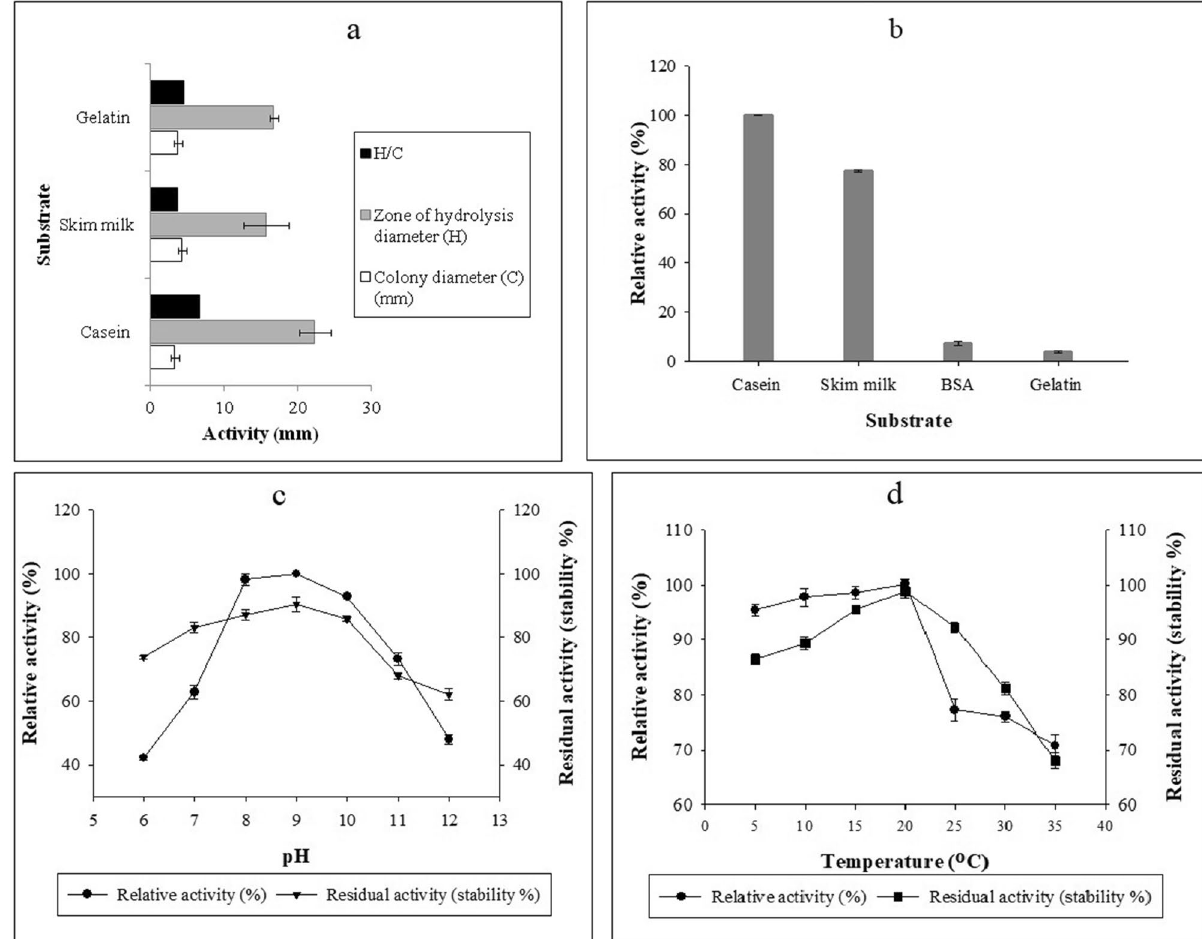
Figure 1. ( a ) Qualitative screening of BO1 strain for its proteolytic activity on three different substrates. ( b ) Substrate efficacy of purified Apr-BO1. ( c ) Effect of pH on the activity and stability of purified cold-active Apr-BO1. ( d ) Effect of temperature on the activity and stability of purified